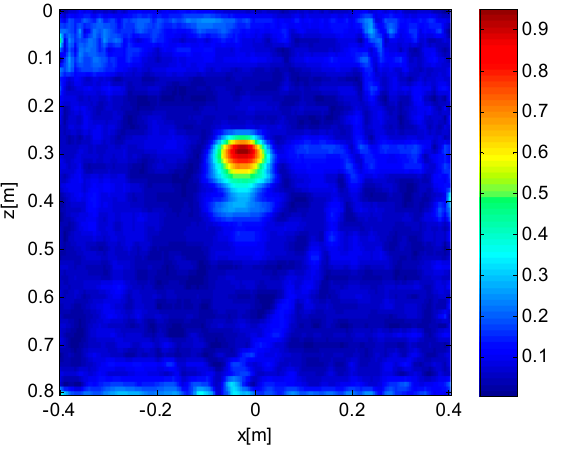
Figure 3. Target reconstruction with an observation domain equal to 1.2 m. Remote Sens. 2017 , 10 , 980